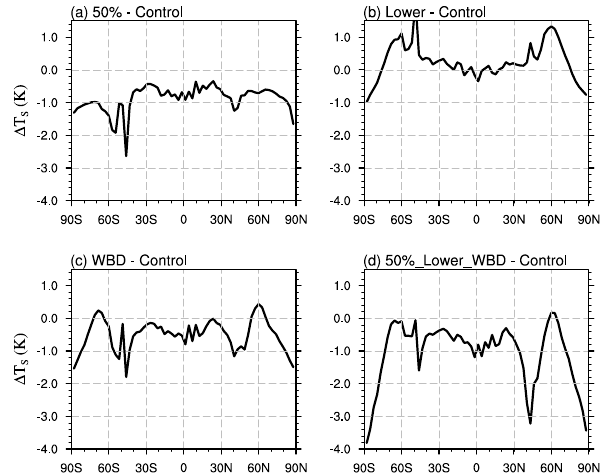
Fig. 2. Differences of annual- and zonal-mean surface air tem- peratures between various ozone scenarios and the control exper- iment for 100ppmv of CO 2 . (a) 50%, (b) lower, (c) WBD, and (d) 50% Lower